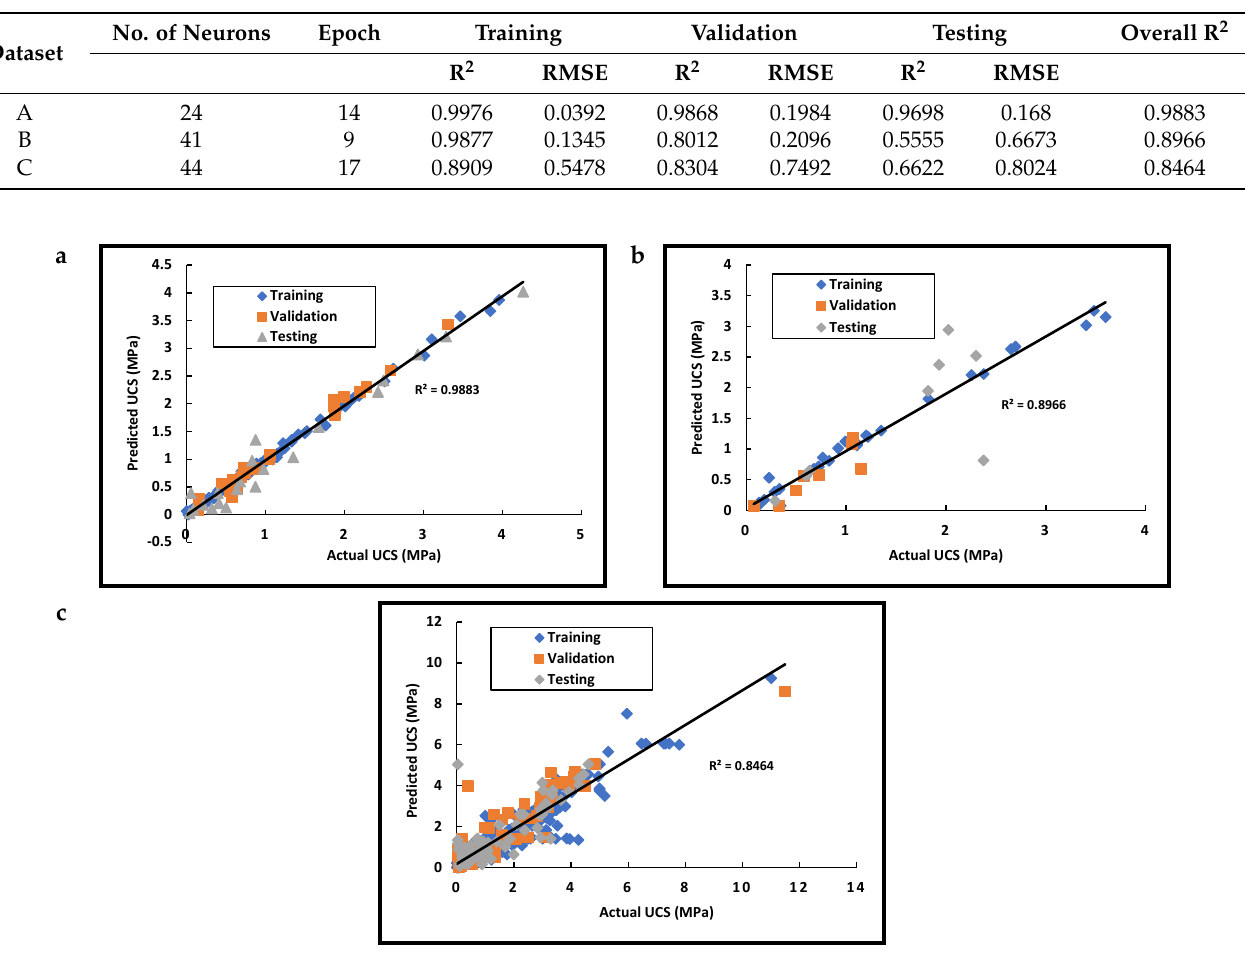
Figure 4. ANN analyses of ( a ) Unstabilized soil (Dataset A); ( b ) Stabilized soil (Dataset B); and ( c ) Stabilized soil (Dataset C).